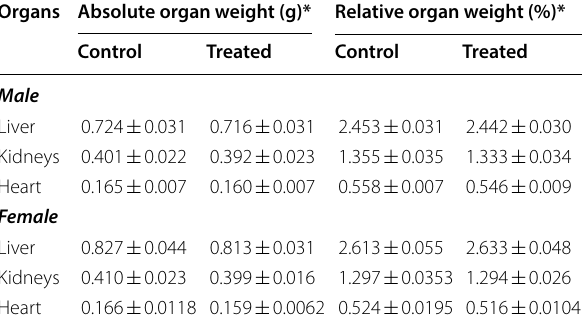
Table 5 Absolute and relative organ weight of control and treated mice (male and female) in the acute toxicity study of Berberis aristata diterpenes